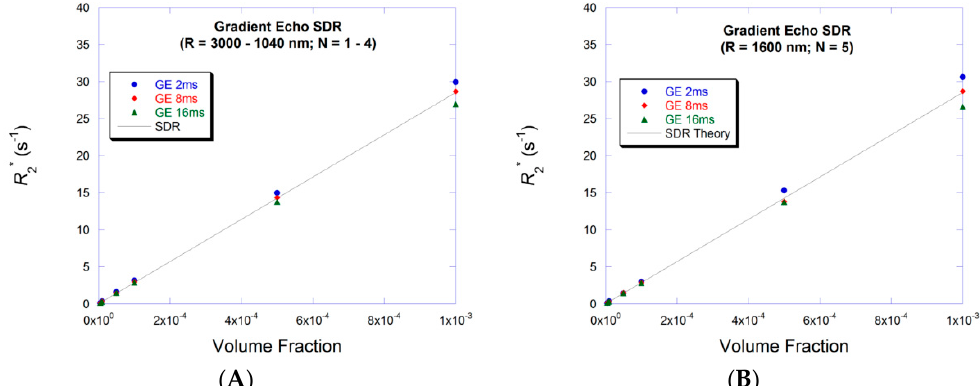
Figure 4. R 2 * values are plotted vs. particle volume fraction for particles within MAR. ( A ) The particle size is increased while the radius is decreased to achieve increasing volume fraction; ( B ) The particle size and radius are kept constant while the sample space is decreased to achieve increasing volume fraction. Static dephasing (SDR) theory manages to correctly predict R 2 * for low particle volume fraction. Data is echo-time independent.